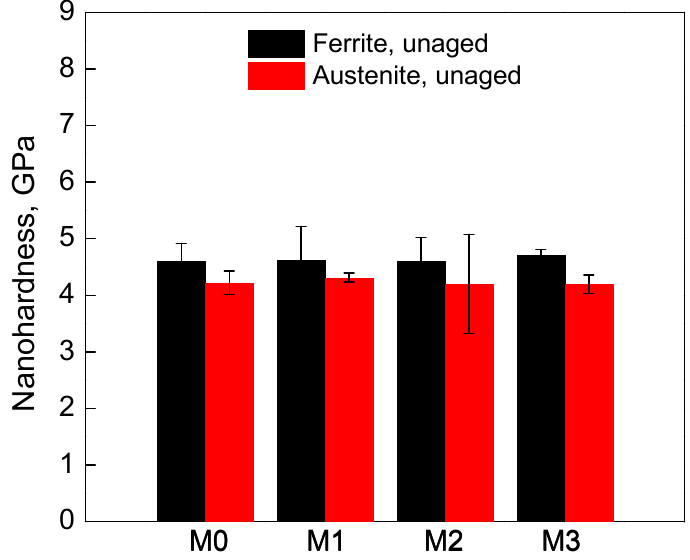
Figure 7. Nanohardness of ferrite and austenite in the unaged CDSS specimens.